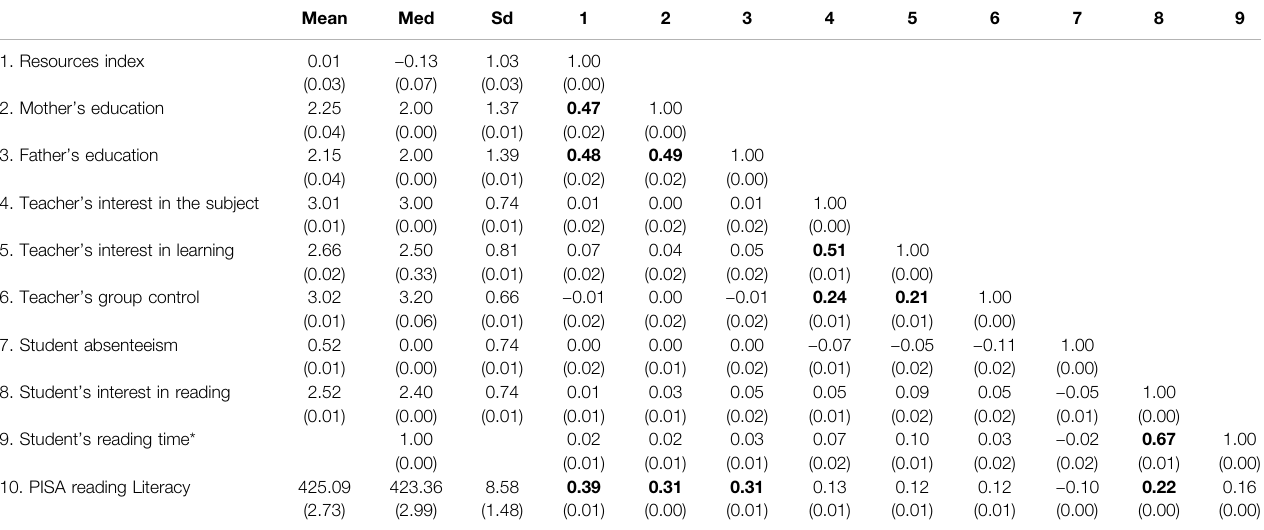
TABLE 1 | Descriptive statistics and correlations of the variables of the study.